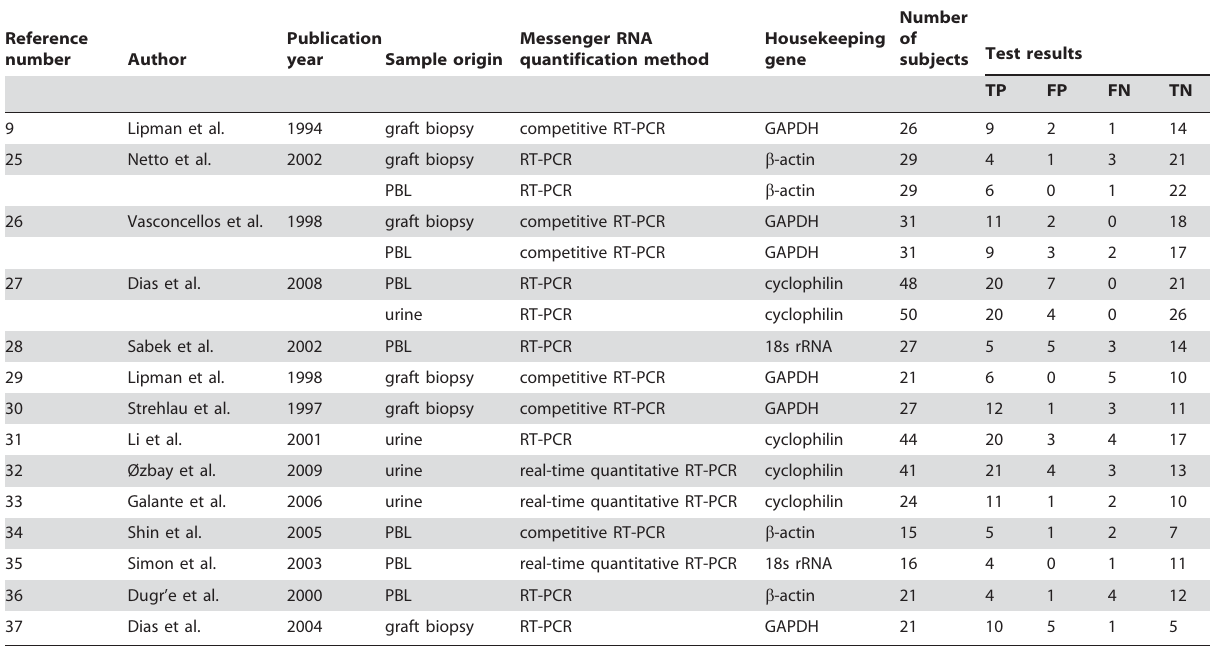
Table 1. Study characteristics of each included